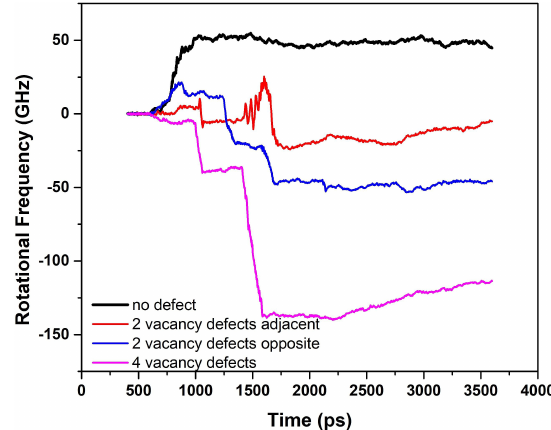
Figure 7: Rotational frequencies of outer tube for the double-walled system containing no defect, 2 vacancy defects adjacent, 2 vacancy defects opposite, 4 vacancy defects in the inner